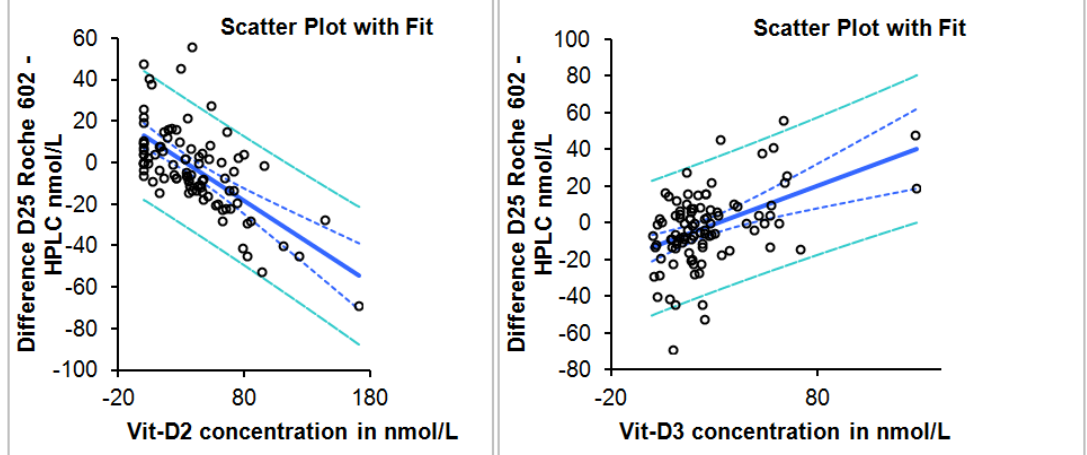
Figure 3. Linear regression analysis scatter plot of the difference in concentration between Roche Diagnostics total 25 (OH) and HPLC as a function of D2 and D3